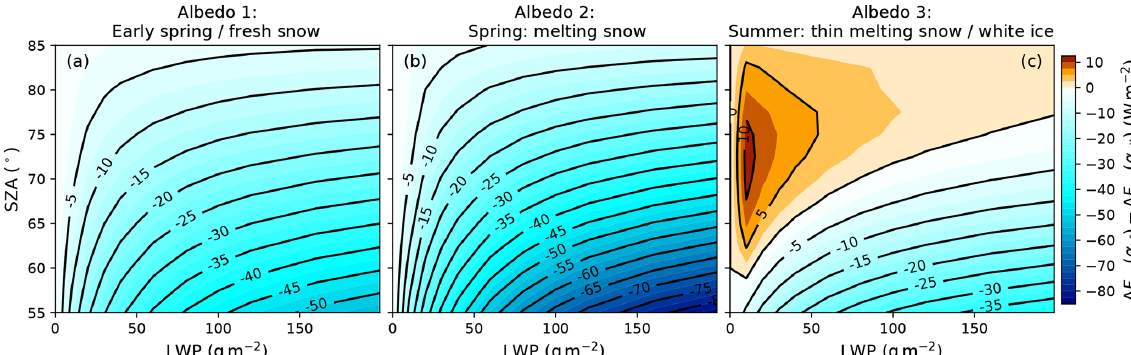
Figure 5. Bias of the shortwave CRF ( (cid:49)F sw (α cf ) − (cid:49)F sw (α all ) ) caused by neglecting the change between observed cloudy and cloud-free surface albedo as a function of cloud LWP ( r eff = 8µm) and SZA. The three albedo types from Fig. 3 have been assumed: (a) fresh snow representative of early spring, (b) melting snow during late spring, and (c) thin melting snow or white ice found in early summer. Negative (bluish) values indicate a stronger shortwave cooling effect for (cid:49)F sw (α cf ) . Changes in direct and diffuse radiation due to SZA are taken into account.